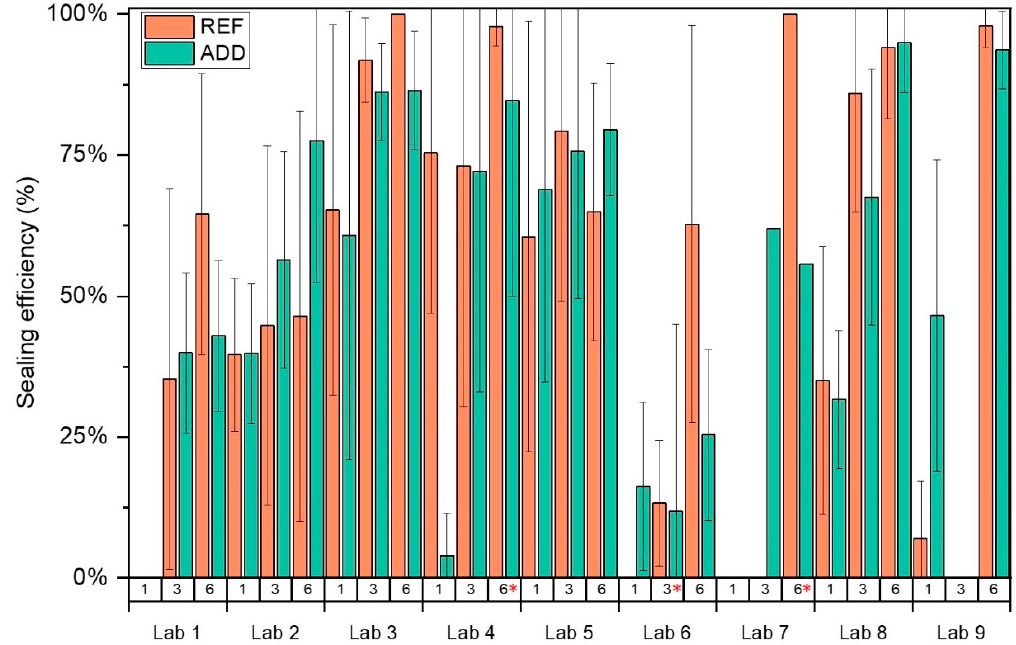
Figure 15. The sealing efficiency SE flow based on water flow tests measured in the different labs. * denotes a longer healing period adopted.